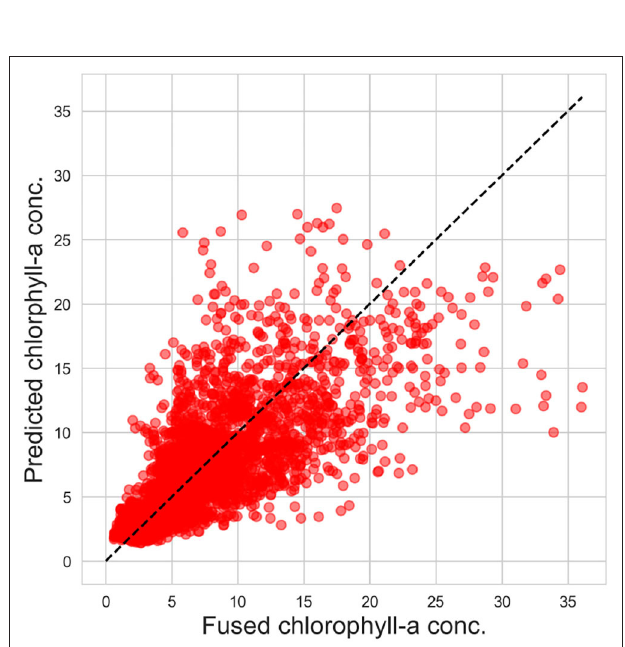
FIGURE 9 | Time series forecasting validation against fused observations. Model fit between 1976 and 2010 (blue) and forecast between 2010 and 2018 (red). Predictive uncertainties in shaded area.